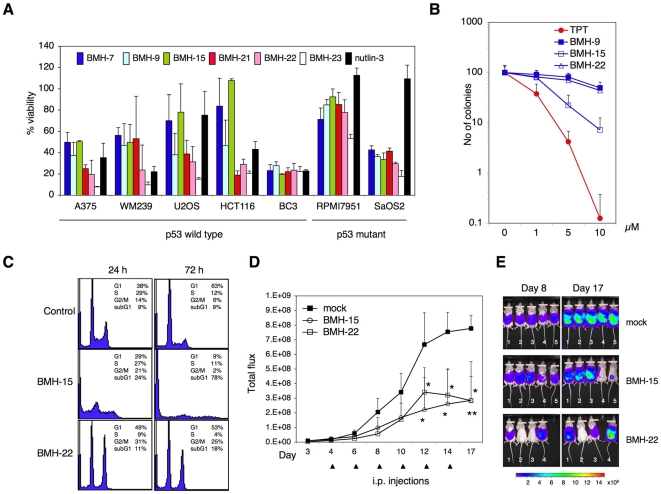
Lead compounds are anti-tumorigenic.A) Tumor cell lines (A375, WM239, RPMI7951 melanoma, U2OS and SaOS2 osteosarcoma, BC3 lymphoma, and HCT116 colon adenocarcinoma cells) were incubated with BMH-7, -9, -15, -22, -23, nutlin-3 (10 µM), and BMH-21 (1 µM) in triplicate for three days. Cell viability was determined using WST-1 cell proliferation assay. Cell viability in control is set as 100%. Error bars represent SD. B) Dose-response curves of normal human CFU-GM. Shown is the clonogenic recovery of normal CFU-GM derived from four healthy individuals, treated with topotecan (TPT), BMH-9, BMH-15 and BMH-22. Error bars represent SD. C) BC3 cells were treated with BMH-15 and BMH-22 (10 µM) for 24 and 72 hours followed by flow cytometry. Cell cycle distribution and fraction of sub-G1 cells are indicated. D) NOD-SCID mice were injected i.p. with BC3luc cells, and tumors were allowed to establish for three days. Tumor take was confirmed by imaging and the mice were treated with i.p. injection of BMH-15 and BMH-22 (20 mg/kg) three times a week. Control animals received DMSO. The mice were imaged prior to each treatment and bioluminescence was quantified and plotted as total flux within a constant ROI. BMH-15 and BMH-22 caused significant reductions in tumor signals (ANOVA analyses, BMH-15, days 12, 14, 17, P values 0.0281, 0.0138, 0.0131, n = 5, respectively; BMH-22, days 12, 14, 17, P values 0.0259, 0.0160, 0.0045, n = 4, respectively; mock, n = 5). Error bars, SD. E) Bioluminescence images of the mice at day 8 and day 17. Heatbar indicates the bioluminescence intensities.